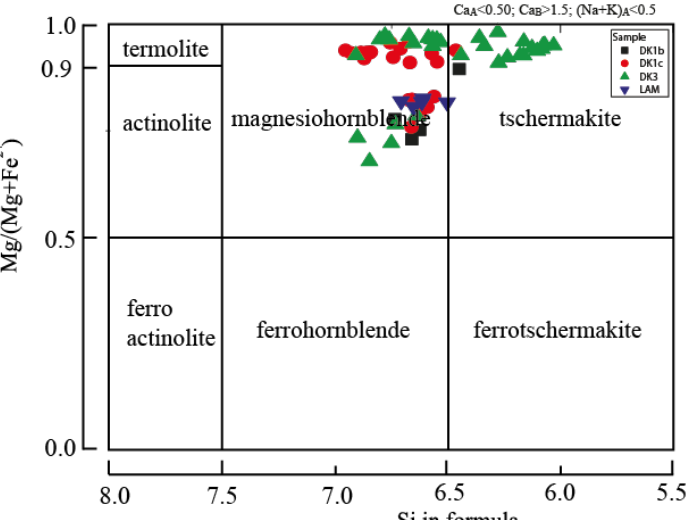
Figure 9. Major element data for amphiboles from dykes of the Sungun deposit plotted on the Mg/(Mg + Fe 2+ ) vs. Si classification diagrams [33]. Table 2. Representative microprobe analysis of amphiboles in Sungun deposit late dykes. Cation calculation is based on 23 oxygen.